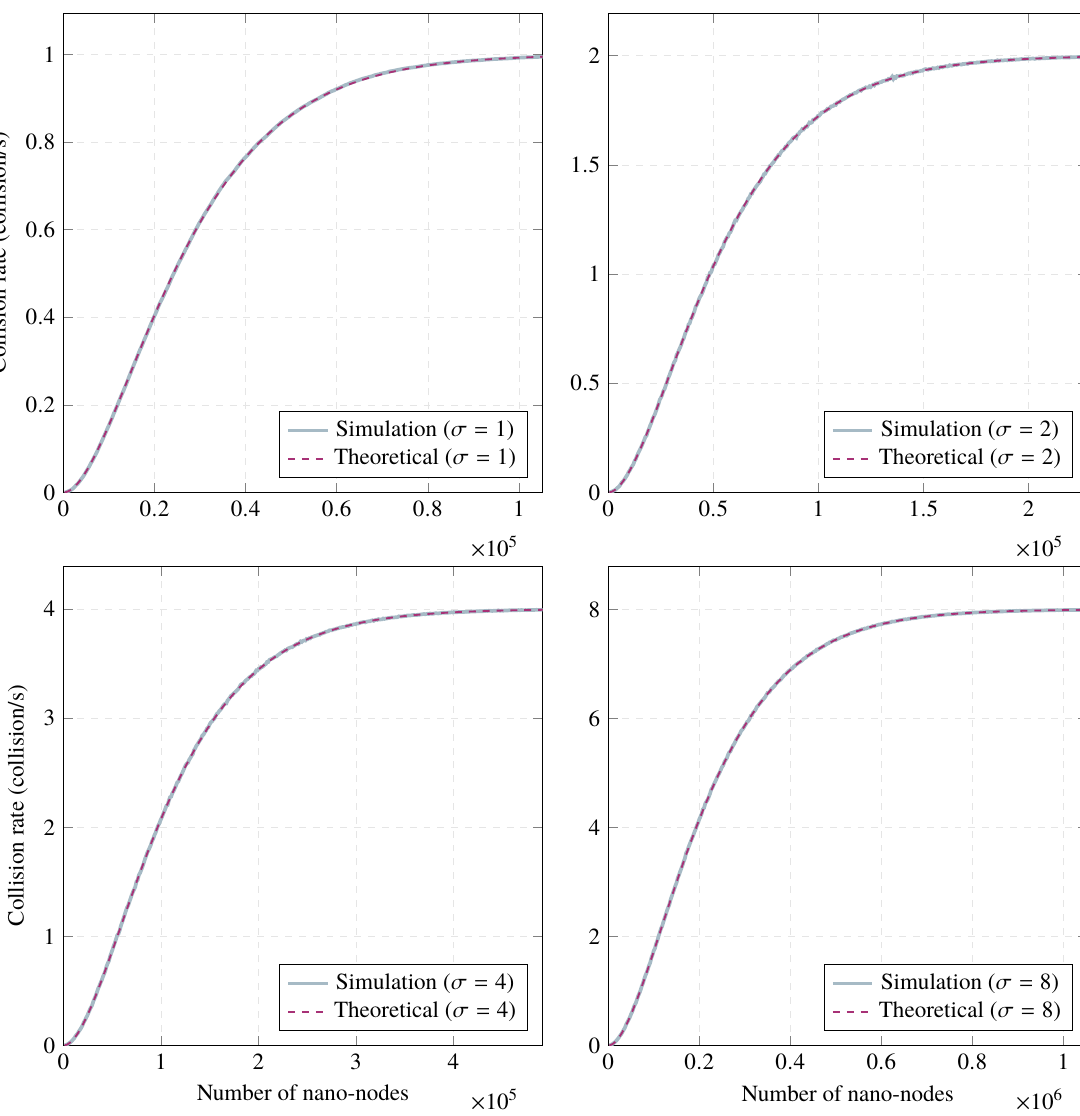
Figure 8. Impact of slots on the network collision rate for A = 1 × 10 − 3 m, f = 1Hz, v = 0.24m / s, T = 60s, and t f =